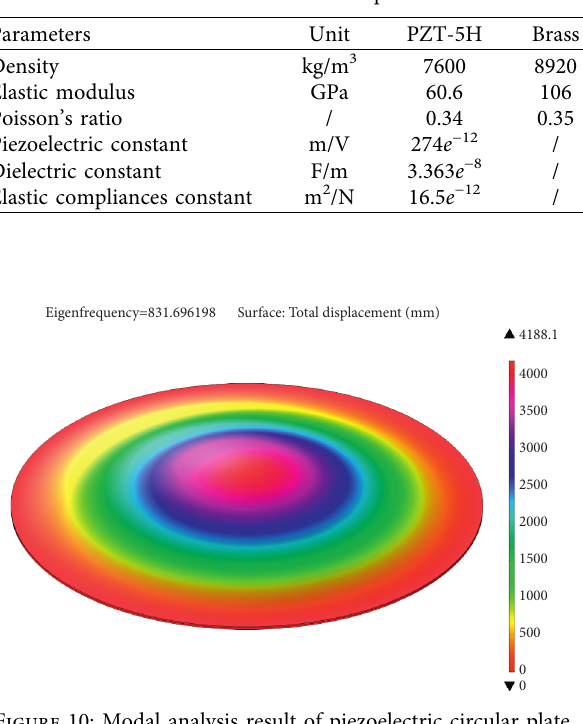
Table 1: Parameters of the PZT-5H piezoelectric film.